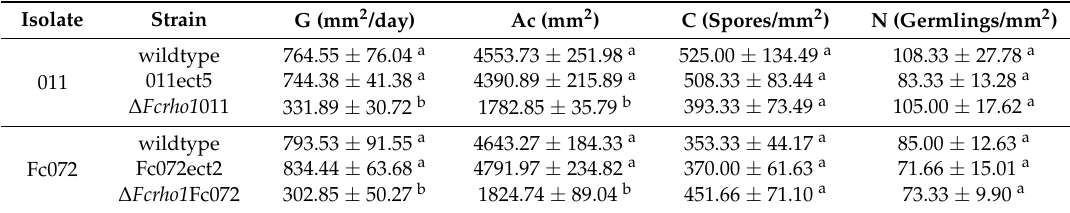
Table 2. In vitro characterization of F. circinatum strains. G: average daily growth rate during 7 days of culture; A c : area of fungal colony after culture for 7 days; C: spore density after 48 h of culture; N: germlings density after 48 h of culture. Small letters (a–b) denote significant differences according to Dunn’s test ( p < 0.05). Mean values and standard errors are shown.